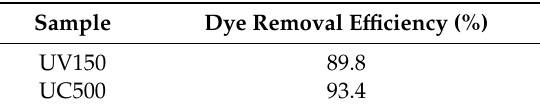
Table 7. Results from the filtration processes.